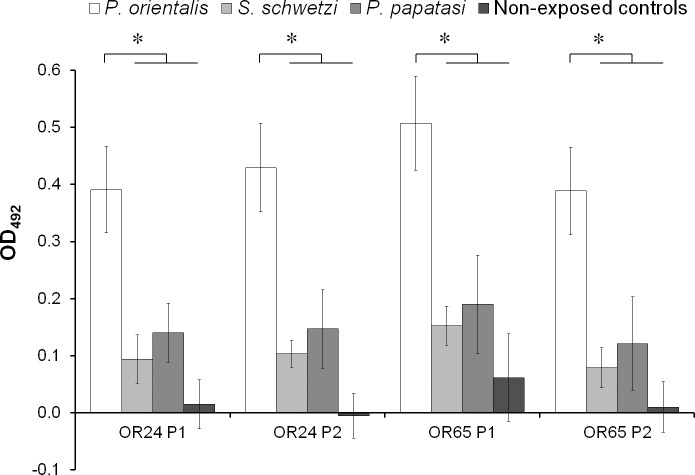
Specificity of peptides.Results from ELISA are presented as mean optical densities (with control values subtracted, from wells without serum) ± standard deviation of IgG antibody reaction, with four peptides (OR24 P1, OR24 P2, OR65 P1 and OR65 P2) and with sera from mice experimentally bitten by P. orientalis, P. papatasi, S. schwetzi, and non-exposed control mice. Five mice per sand fly colony and five non-exposed controls were used. Cut-off values were 0.144 for OR24 P1, 0.112 for OR24 P2, 0.292 for OR65 P1, and 0.143 for OR65 P2. Asterisks (*) indicate significant differences (p < 0.05, calculated with non-parametric Wilcoxon Rank-Sum Test) between IgG levels of mice bitten by P. orientalis, bitten by other sand fly species, and unbitten controls.